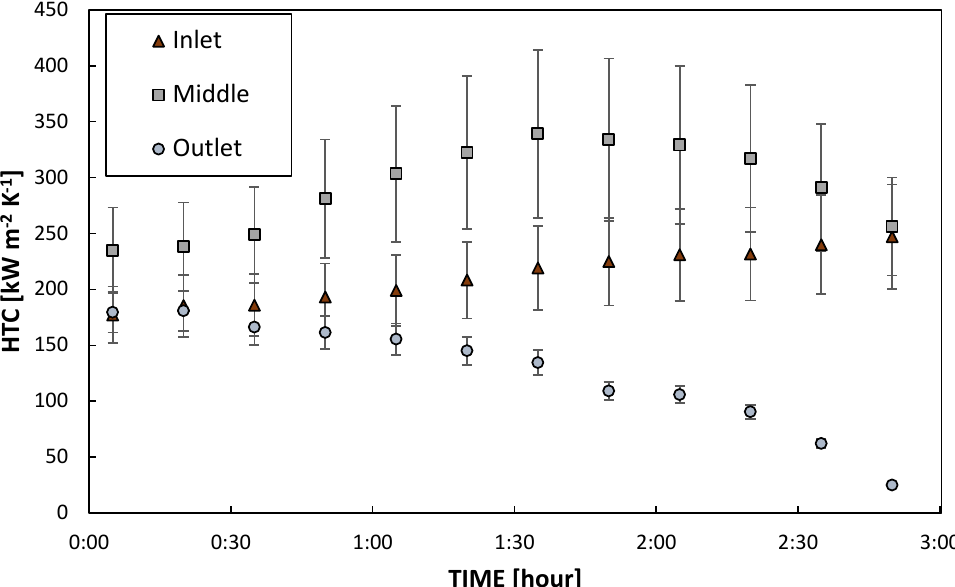
Figure 7. Time evolution of the HTC during dropwise condensation (DWC) on M7T3_300 sample in different areas.